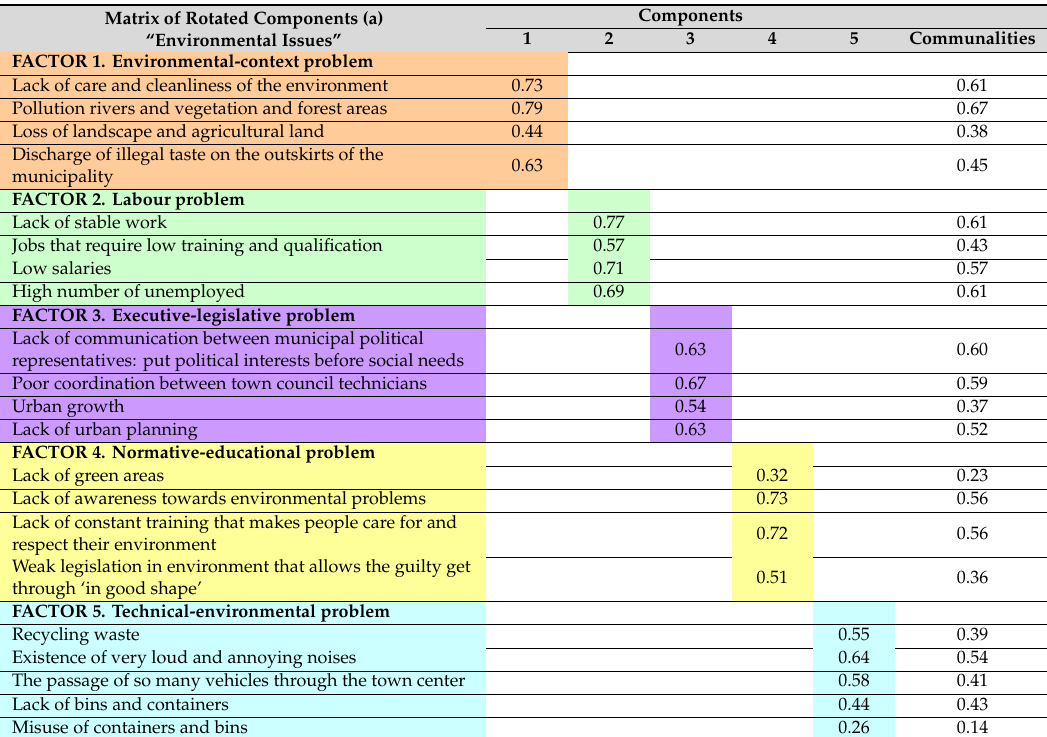
Table 7. Extraction method: analysis of main components. Rotation method: varimax normalization with Kaiser.